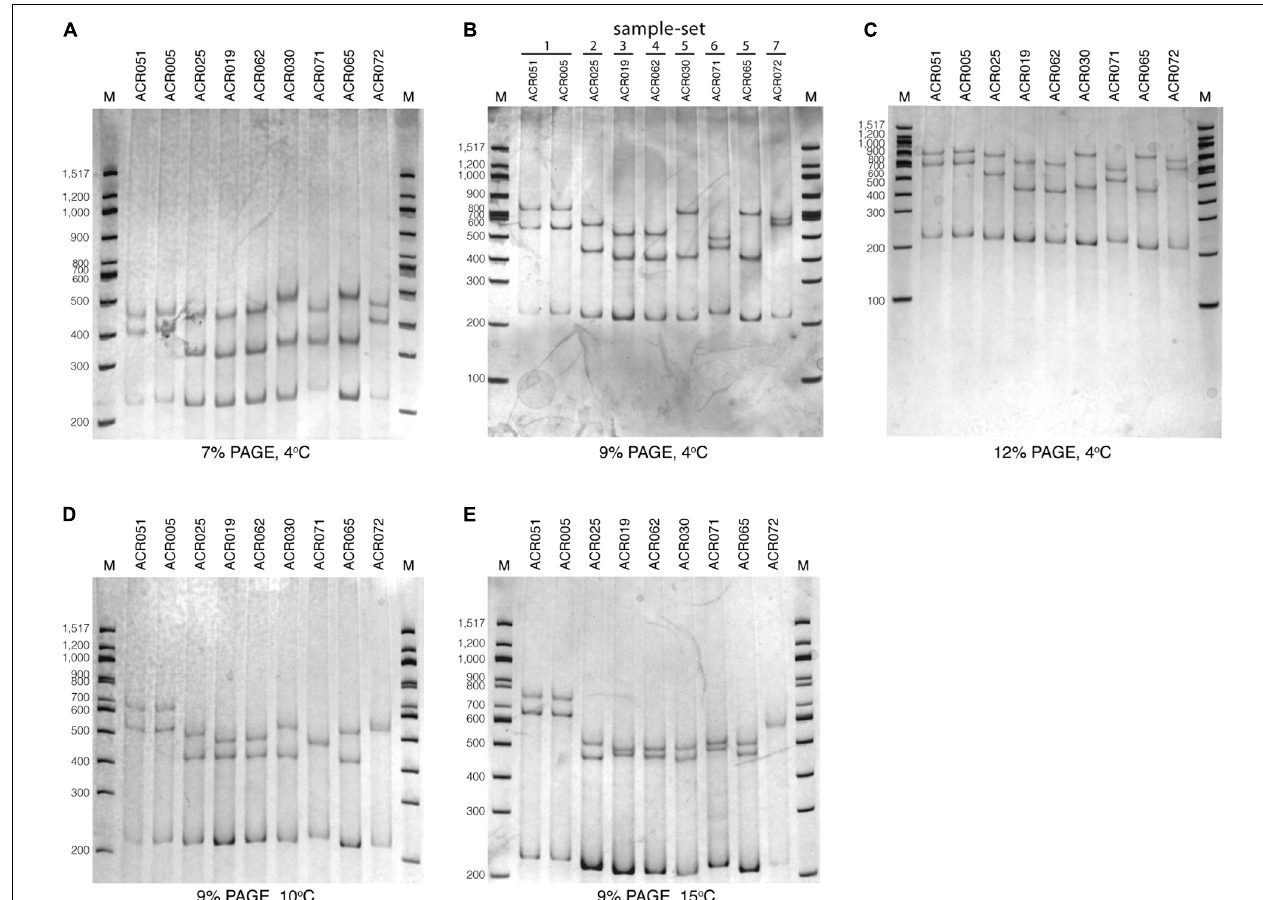
FIGURE 3 | Polyacrylamide gel electrophoresis (PAGE) of the single-strand conformation polymorphism (SSCP) fingerprint under numerous conditions. The SSCP fingerprint method was optimized under several acrylamide concentrations, including 7% (A) , 9% (B) , and 12% (C) and also various temperatures, including 4 ◦ C (B) , 10 ◦ C (D) , and 15 ◦ C (E) . All PAGEs were run at 130 V, 4 ◦ C for 3 h, followed by silver staining. Lanes 1–9 are nine dictyostelid samples selected according to the previous phylogenetic tree analysis (Rukseree et al., 2018). The 100-bp DNA ladder (New England Biolabs, United States) was used as the reference marker (lane